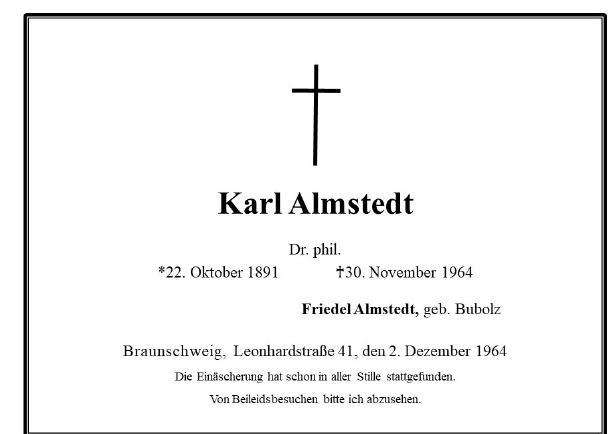
Figure 6. Death notice by Friedel Almstedt. The detailed infor- mation reads as follows. The cremation has already taken place in private. I ask you to refrain from visits of condolence . Reproduced from the Braunschweiger Zeitung . No. 282, 3 December